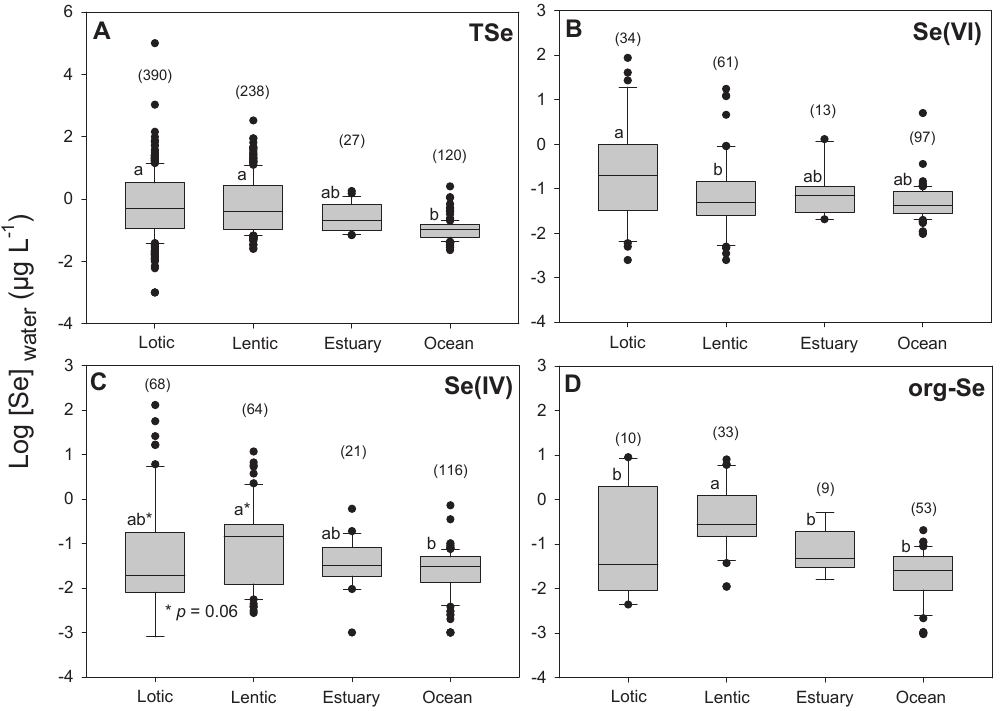
Figure 4. Boxplot of log-transformed ( A ) total dissolved selenium (TSe), ( B ) selenate (Se(VI)), ( C ) selenite (Se(IV)), and ( D ) organic selenium (org-Se) concentrations in water ( μ g L -1 ) for different aquatic systems categories (Lotic, Lentic, Estuary, Oceans (and seas)). Number of samples is presented in parentheses. Significant differences (analysis of variance (ANOVA) followed by Tukey’s test; p < 0.05) are presented by different lower-case letters.